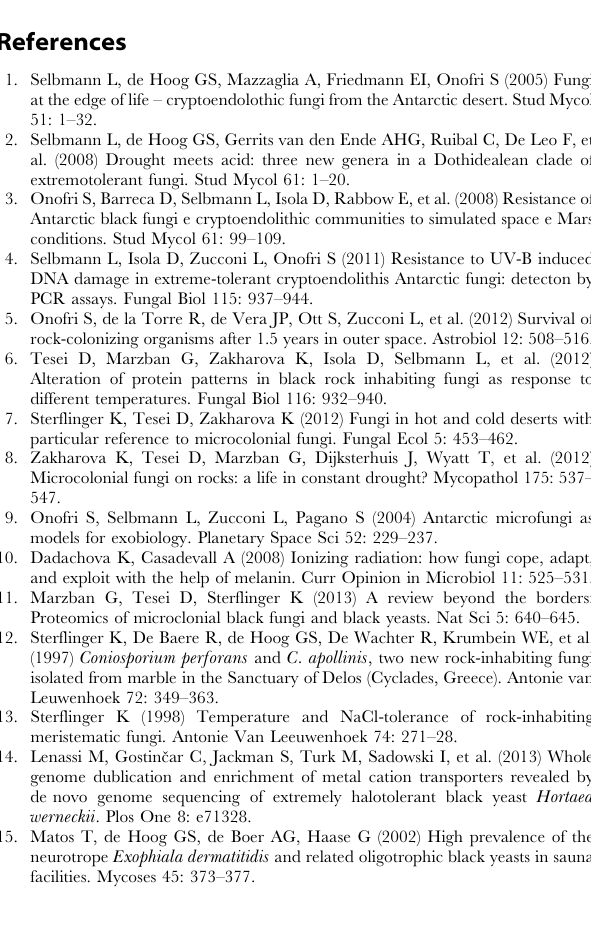
Table S3 Mating gene homology analysis of C. apolli- nis . (XLSX) Table S4 Mating gene homology analysis of C. sphaer- ospermum . (XLSX) Table S5 Mating gene homology analysis of E. derma- titidis . (XLSX) Table S6 Mating gene homology analysis of H. wer- neckii .